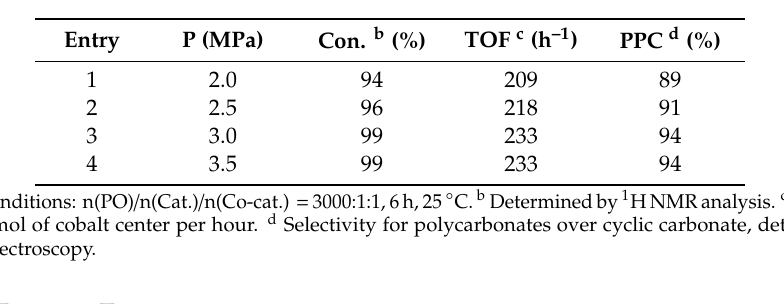
Table 3. (Salen- 4 )[Co(III)TFA] 2 / [PPN]TFA catalyzed PO / CO 2 copolymerization under different pressure a .